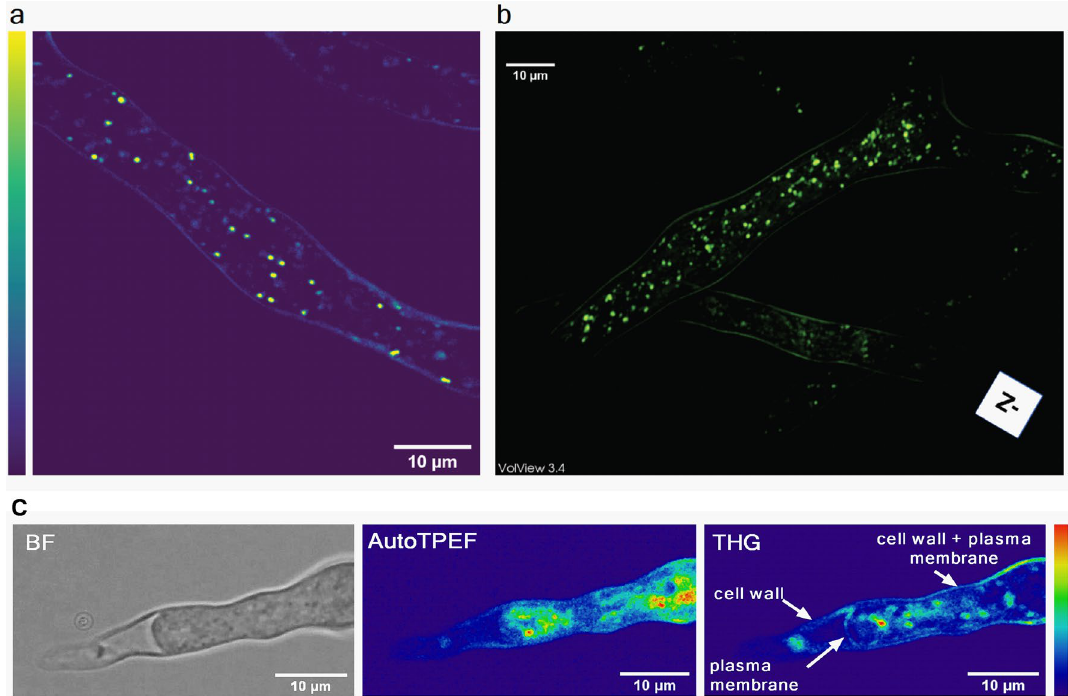
Figure 3. Label-free imaging of Phycomyces blakesleeanus hyphae from the exponential phase in SLM. ( a ) one THG slice; ( b ) 3D model built out of 23 THG slices 0.9 µm apart. The average laser power at sample plane was 23–26 mW. ( c ) Multimodal imaging: bright field (BF) (left), autoTPEF (middle) and THG (right) images of the same live unlabeled hypha. The hypha was plasmolyzed and the retracted plasma membrane is solely visible in the THG image. The average laser power at sample plane was 2.7 mW (TPEF) and 55 mW (THG). Color intensity bar for both, TPEF and THG signals: deep blue—the lowest signal, red the highest signal. All the images were taken with Zeiss 40 × 1.3 oil objective